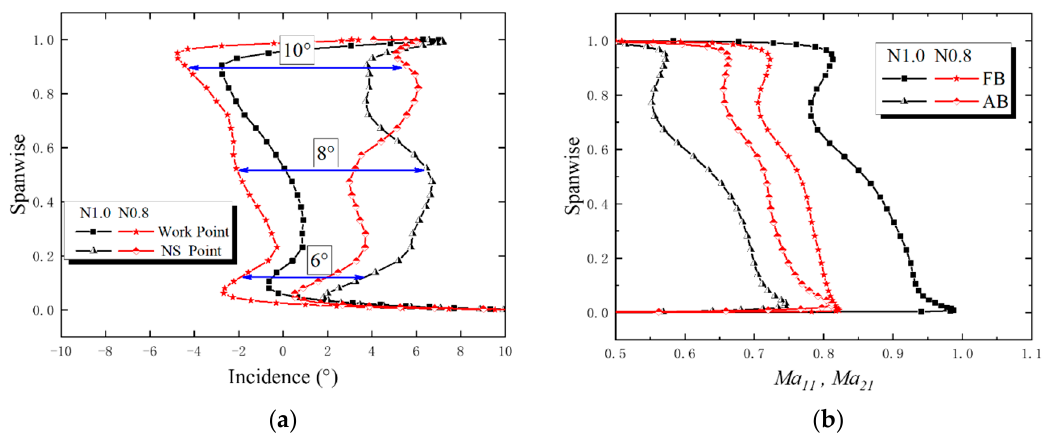
Figure 21. Operating conditions of the tandem stator at design speed and off design speed. ( a ) Incidence range; ( b ) inlet Mach number.